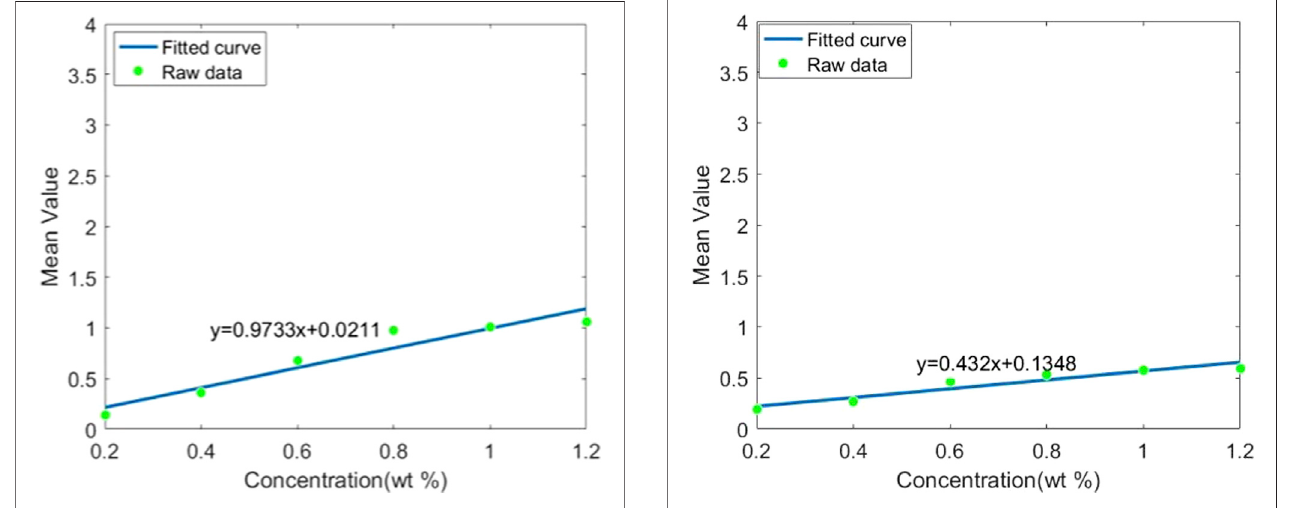
FIGURE 8 | Fluorescence ef fi ciency of Bi.